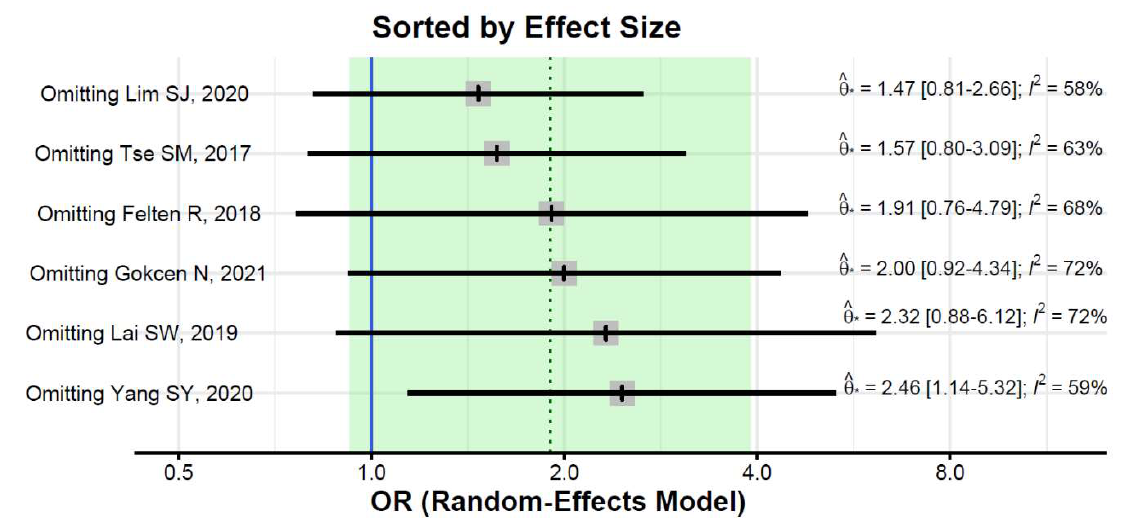
Figure 5. Leave-one-out sensitivity analyses [31–36].